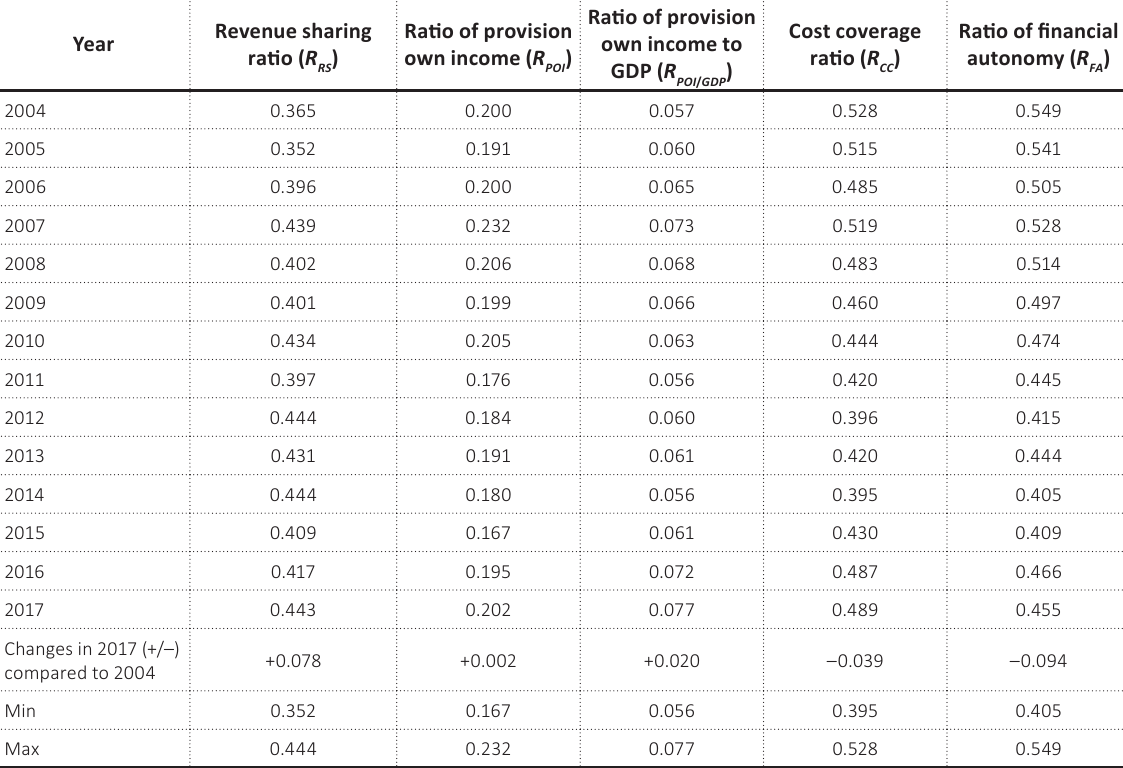
Table 2. Fiscal policy decentralization indicators by the influence on the formation of local budget